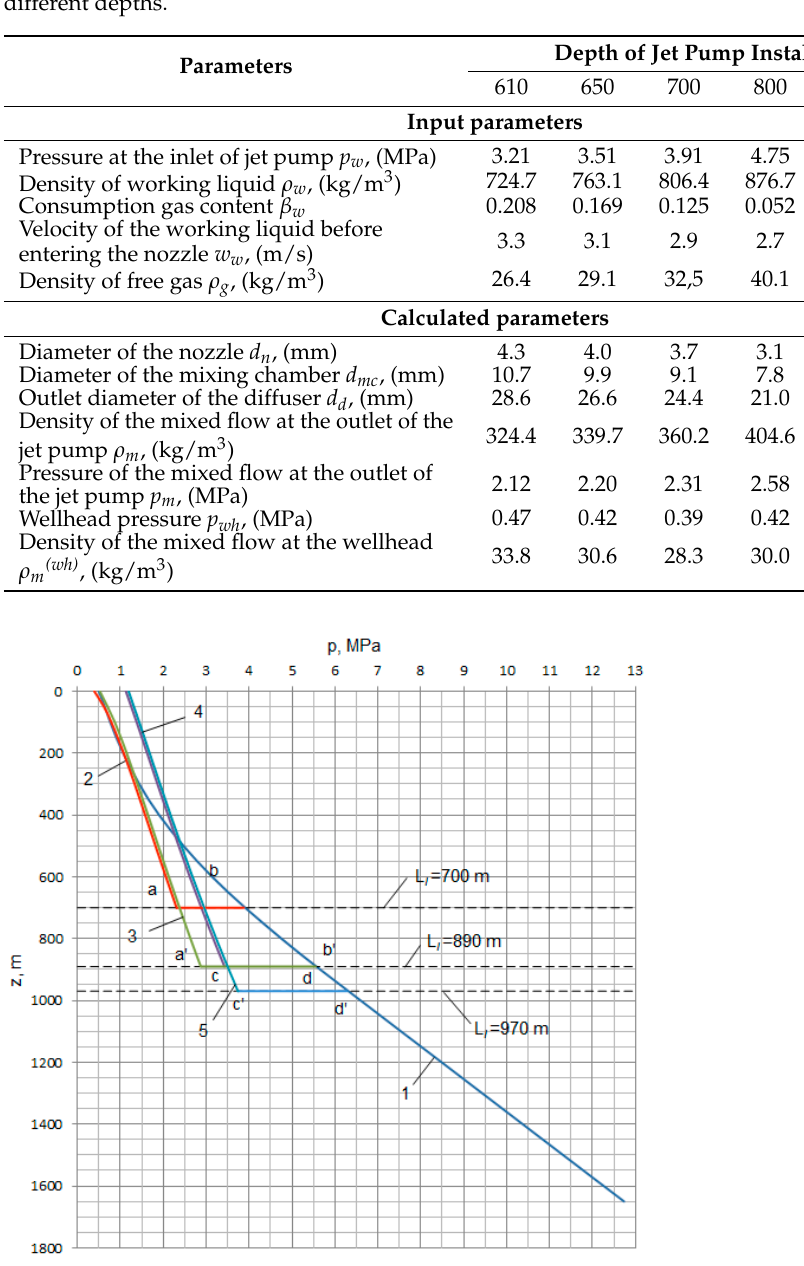
Figure 3. Pressure distribution along the wellbore between jet pumps and wellhead: 1—wellbore pressure distribution; 2, 3—pressure distribution after using jet pump with f 3 / f 1 = 6.25; 4, 5—pressure distribution after using jet pump with f 3 / f 1 = 4. Curves 2 and 3 correspond to jet pumps with the cross-sections ratio f 3 / f 1 = 6.25 and curves 4 and 5 correspond to jet pumps with the cross-sections ratio f 3 / f 1 = 4. In addition, the pressure distribution in oil well between the sucker-rod pump and the wellhead